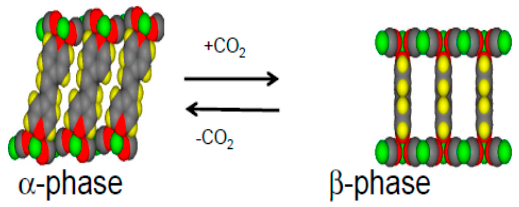
Figure 1. Schematic drawing demonstrating the opening/collapsing (decreasing/increasing the angle between the basal plane and the ligand) of the unit cells of Ni(L)[Ni(CN) 4 ] in the presence of CO 2 .